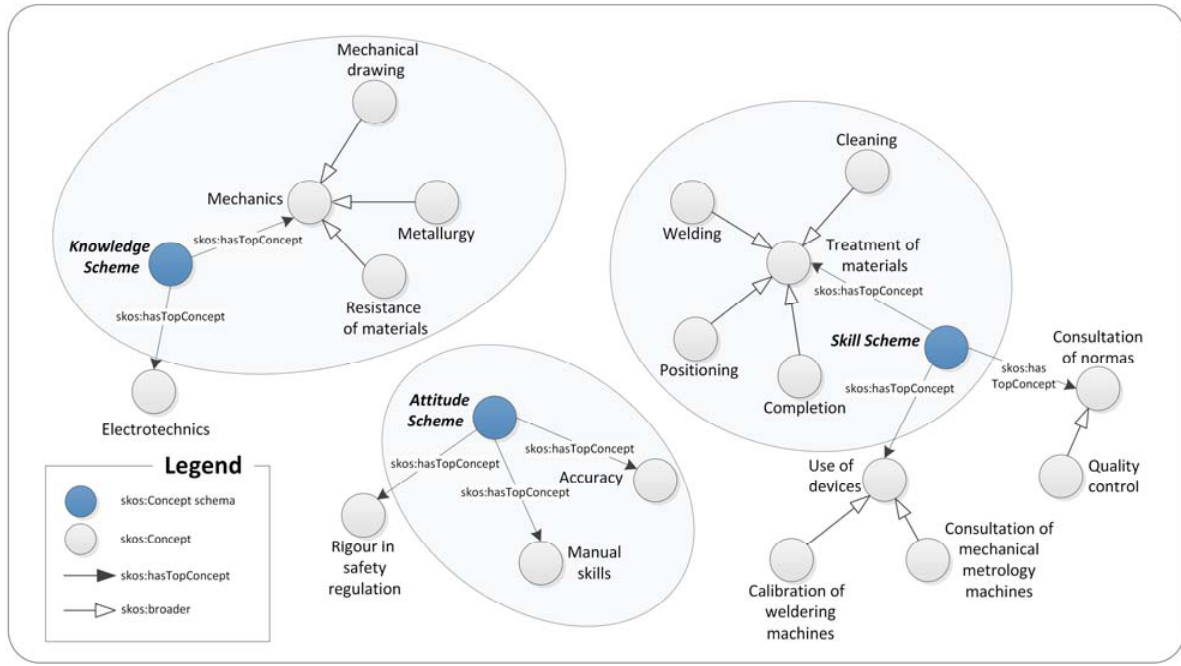
Figure 2. A portion of